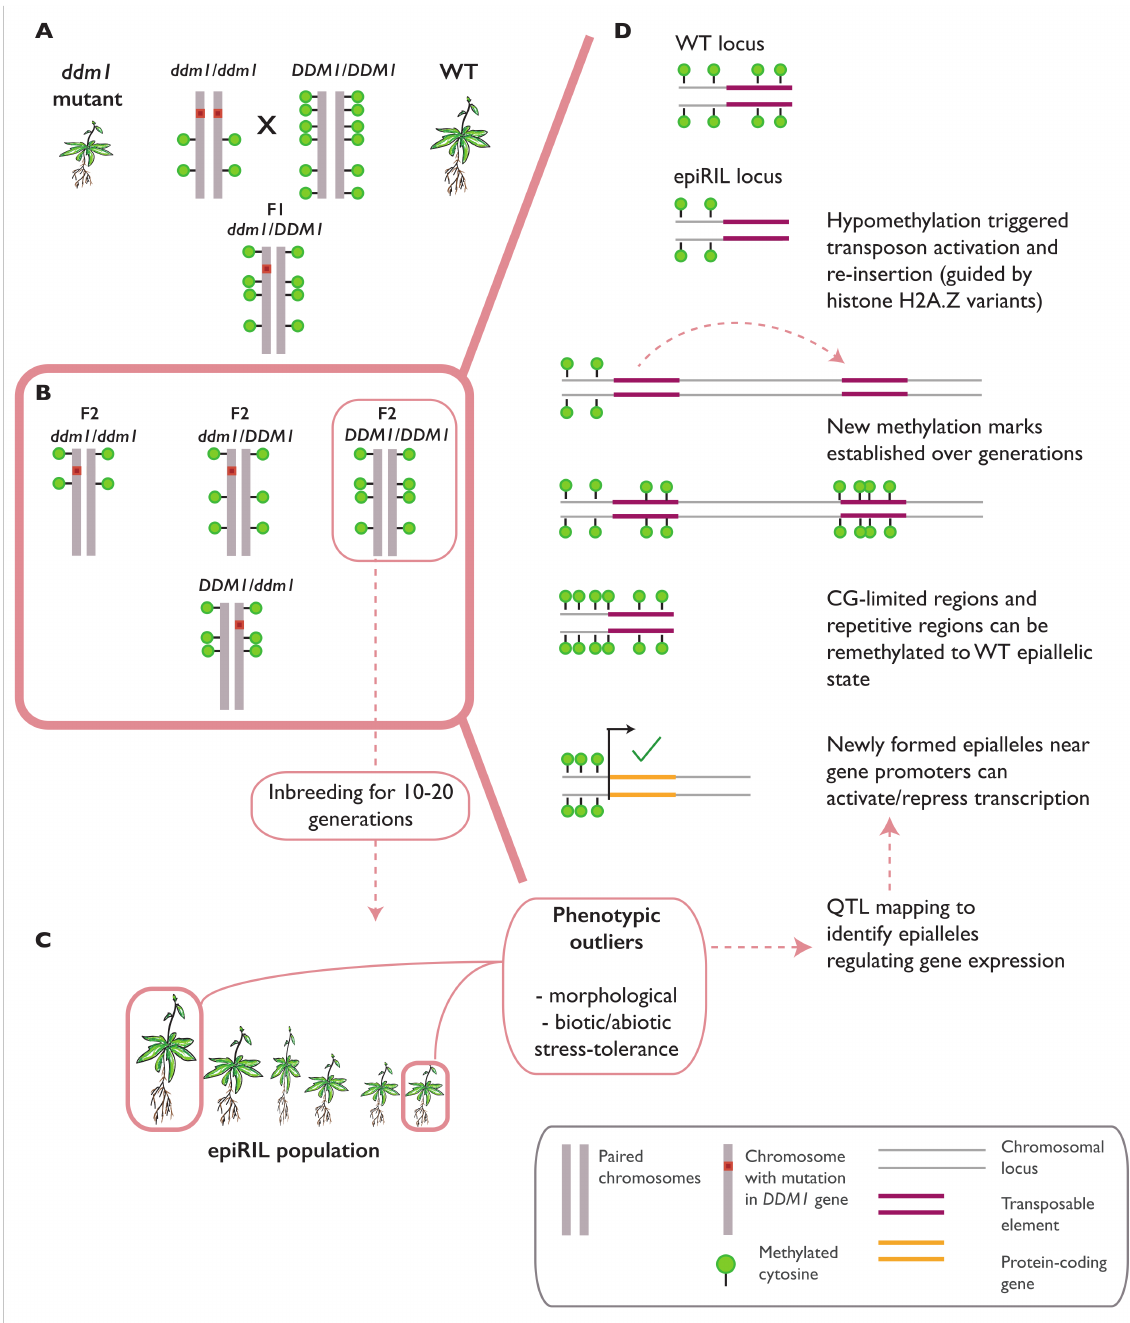
Figure 2. Identification of novel epialleles by epiRIL generation. Genome-wide methylation patterns can be redistributed by crossing wild-type (WT) plants with mutants defective in DNA methylation (such as the ddm1 mutant) ( A ). Progeny from such crosses carrying the WT alleles (DDM1/DDM1) are selected for multigenerational inbreeding ( B ), ultimately generating epigenetic recombinant inbred lines (epiRILs). The epiRIL population can be tested for variations in several morphological or stress resistance traits to identify the phenotypic outliers ( C ). These lines are ultimately chosen for an epigenetic quantitative trait loci (epiQTL) analysis to identify the novel epialleles underlying the measured traits. Such epialleles in epiRIL lines can occur due to the activation of transposable elements (TEs) and their subsequent reinsertion into distal loci, often determined by chromatin properties and the nature of the target sequence (CG content) ( D